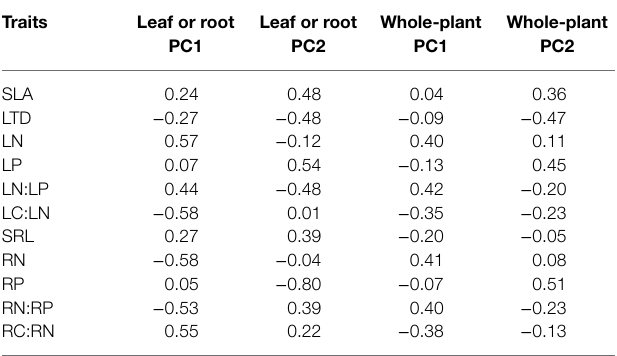
TABLE 1 | Coefficients for eigenvectors for main axes of principal component analyses (PCAs) on leaf and/or fine-root traits. Traits Leaf or root Leaf or root PC1 PC2